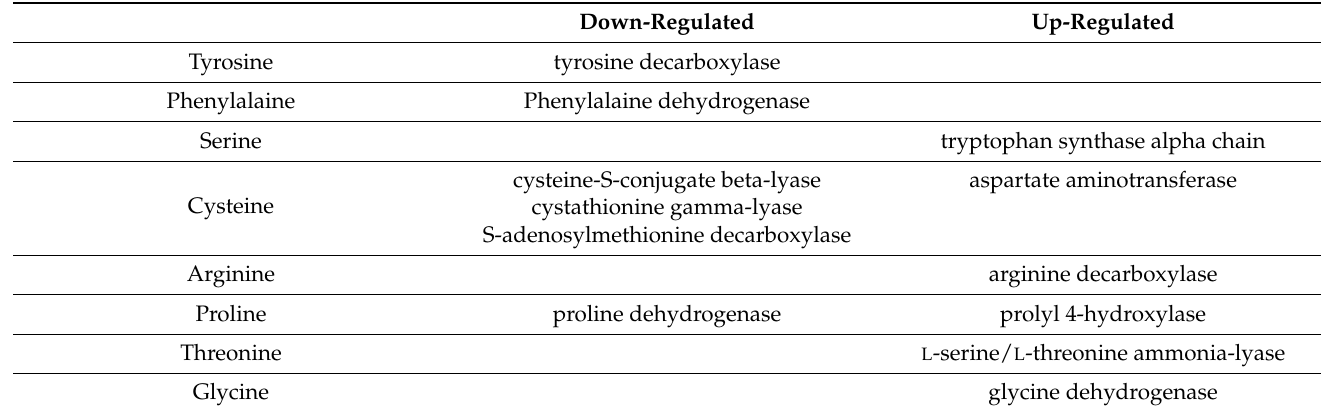
Table A8. Main DEGs in amino acid degradation pathways (gall vs. LWG).